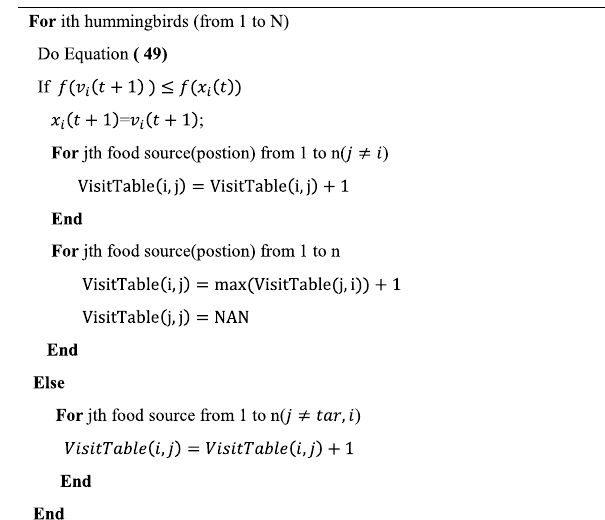
Algorithm 2. Territorial forging for AHA.